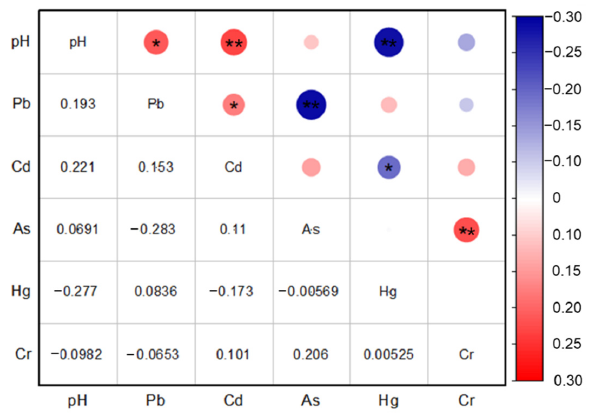
Figure 8. Correlation coefficient matrix of heavy metals in bamboo shoot soil. ** significant at the 0.01 level (2-tailed); * significant at the 0.05 level